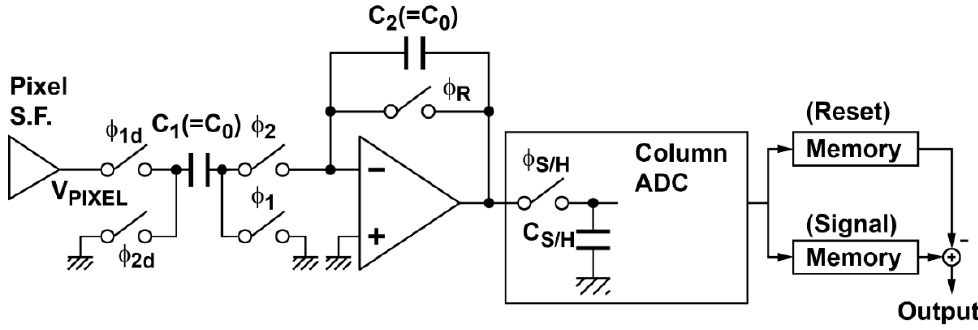
Figure 2. Schematic diagram of the column readout circuits using multiple sampling for low-noise readout.